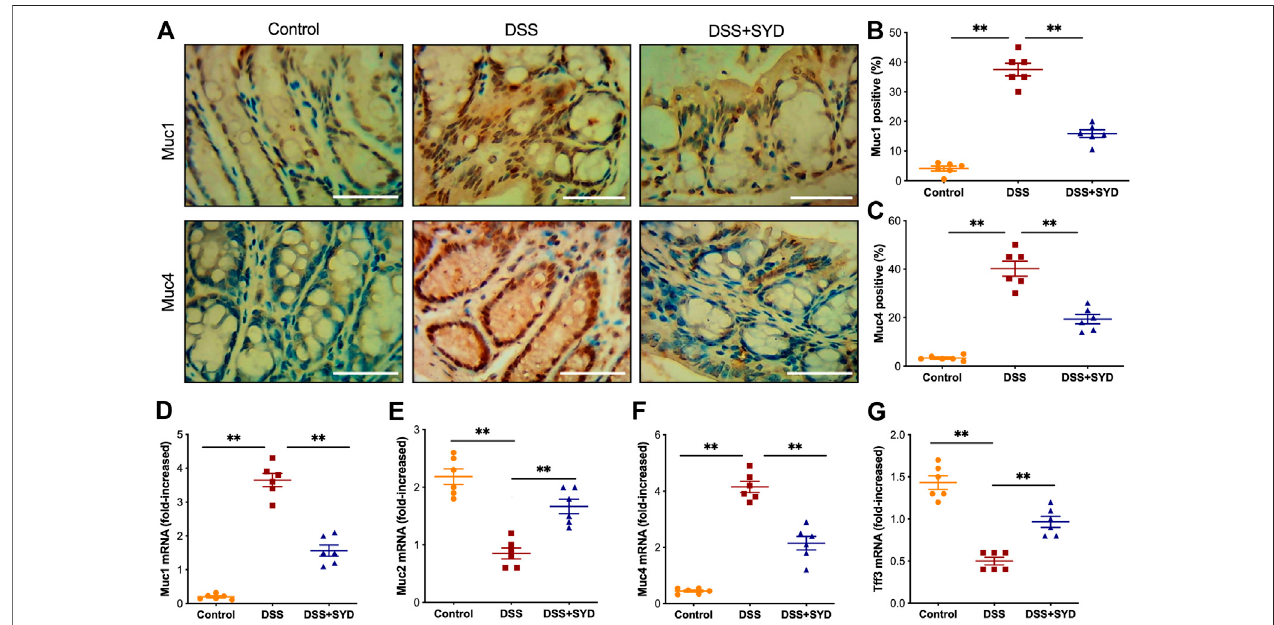
FIGURE 6 | SYD improves colonic mucus barrier function in DSS-treated mice (A) Immunohistochemistry of Muc1 and Muc4 in colon sections. Scale bars (cid:2) 100 μ m (B,C) GraphicalrepresentationofthepercentageofMuc1andMuc4inmid-colon (D – G) Expressionof Muc1,Muc2,Muc4, and Tff3 wasevaluatedbyreal-time PCR. Data are presented as the mean ± SEM, n (cid:2) 6 per group. * p < 0.05, ** p <